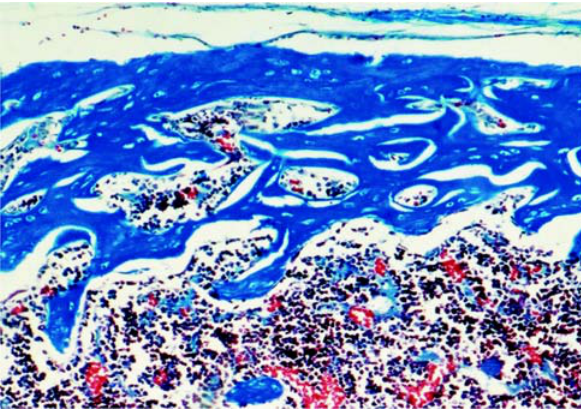
FIGURE 5- Group DC30: Surgical defect repaired by disorganized bone tissue with remnant of wide intratrabecular spaces and cortical thickness decrease at the defect central area. Masson’s Trichrome (Original magnification x63)